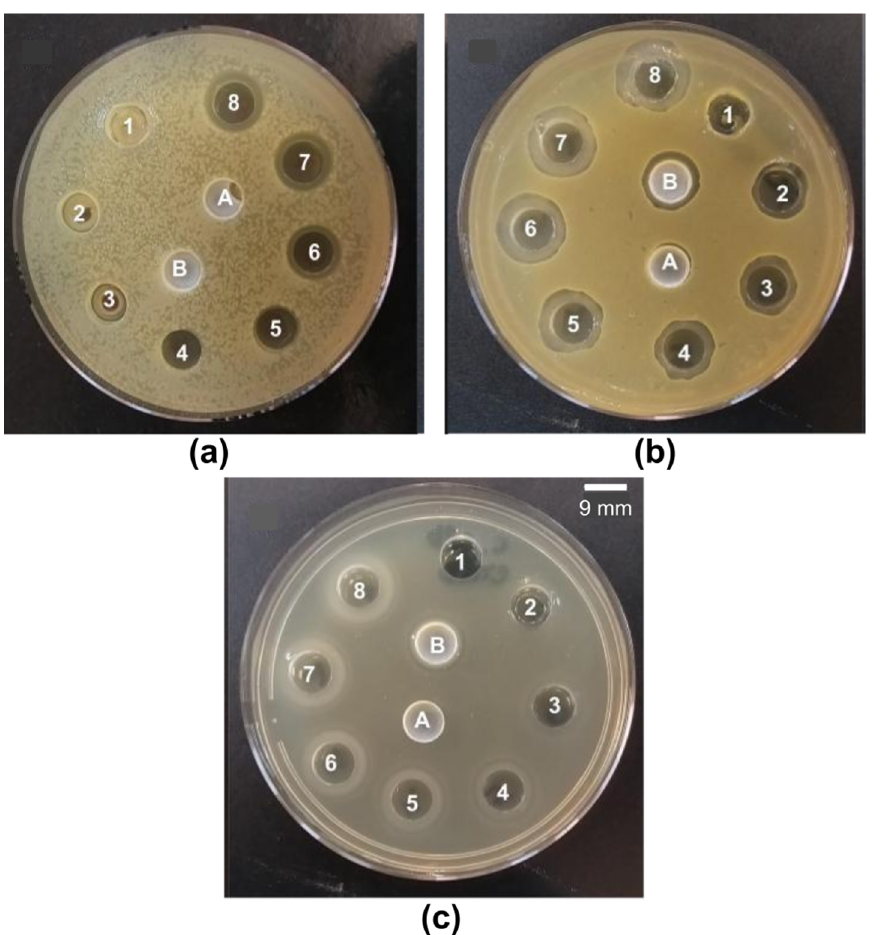
Figure 4. (a) E. coli, (b) S. aureus, and (c) C. albicans inhibition halos induced by CTAB alone (numbered from 1 to 8) or by PMMA/CTAB dispersions after (A) or before dialysis (B). From 1 to 8, [CTAB] inside the wells was 0.01, 0.2, 0.3, 0.5, 1.0, 1.5, 2.0, and 2.5